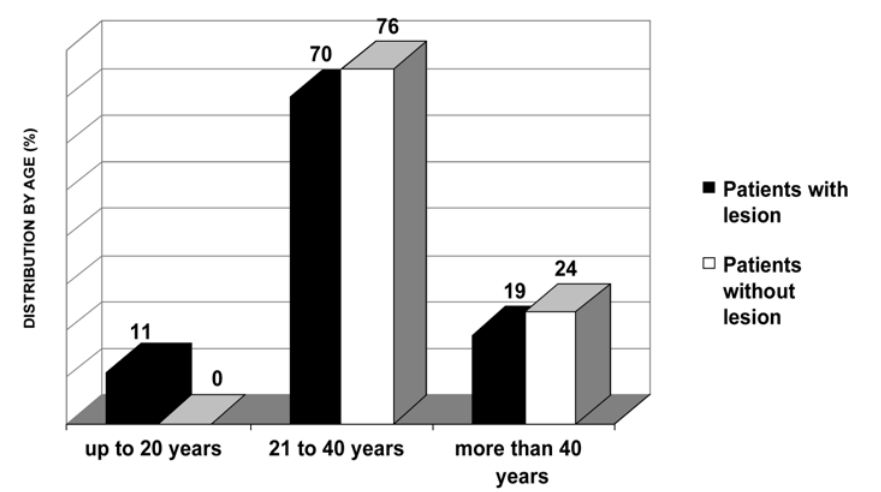
FIGURE 2- Distribution (%) of patients by